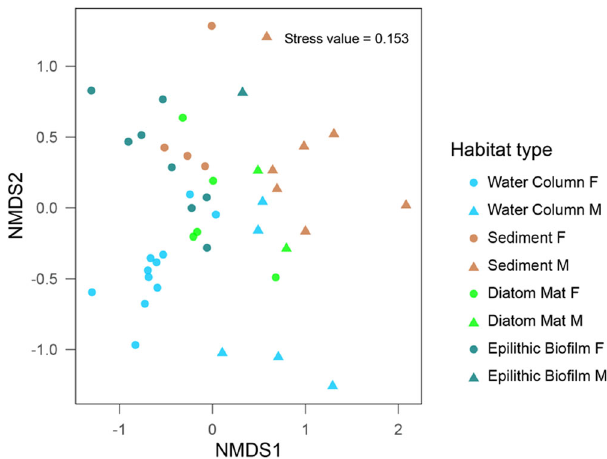
Fig. 7 Diatom community analysis. NMDS plot of Bray – Curtis dissimilarities from 43 diatom communities with a total of 2157 amplicon sequence variants (ASVs) retrieved from different habitat